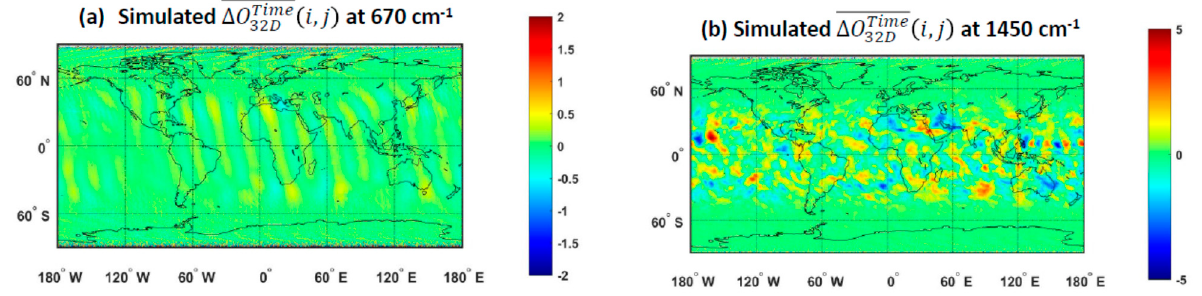
Figure 5. Global distributions of simulated 32-day-averaged ∆𝑂 (cid:2871)(cid:2870)(cid:3005)(cid:3021)(cid:3114)(cid:3040)(cid:3032) (cid:3364)(cid:3364)(cid:3364)(cid:3364)(cid:3364)(cid:3364)(cid:3364)(cid:3364)(cid:3364)(cid:3364)(𝑖,𝑗) (𝑇 (cid:3003) difference) at 670 and 1450 cm − 1 corresponding to the orbit time difference of NOAA-20 and SNPP satellites which were calculated using (12) based on 32-day simulations from 27 September to 28 October 2019. ( a ) 670 cm − 1 . ( b ) 1450 cm − 1 .